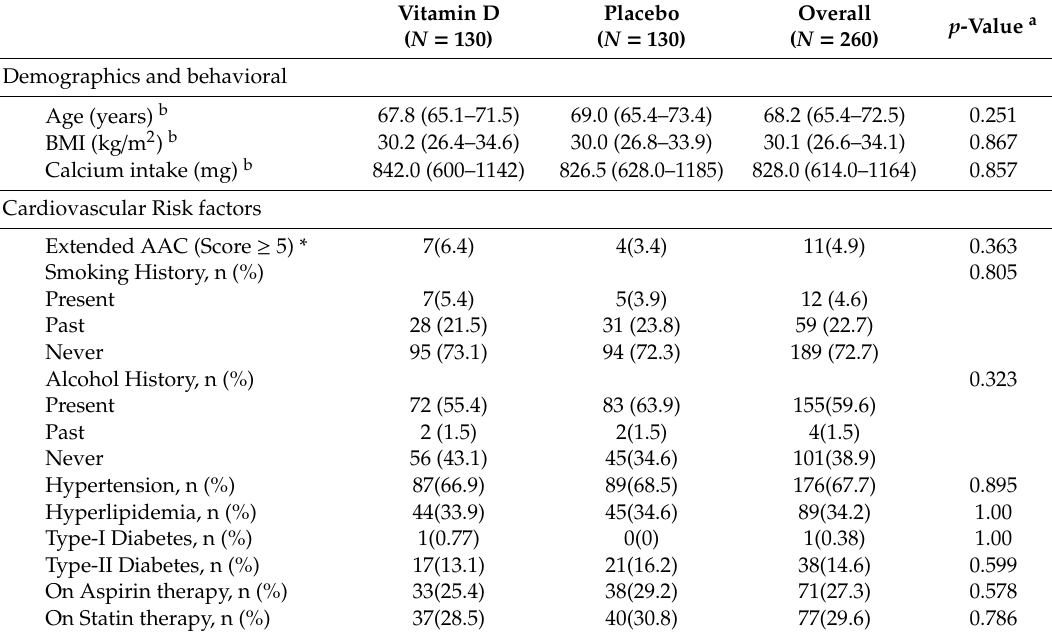
Table 1. Baseline demographics and clinical